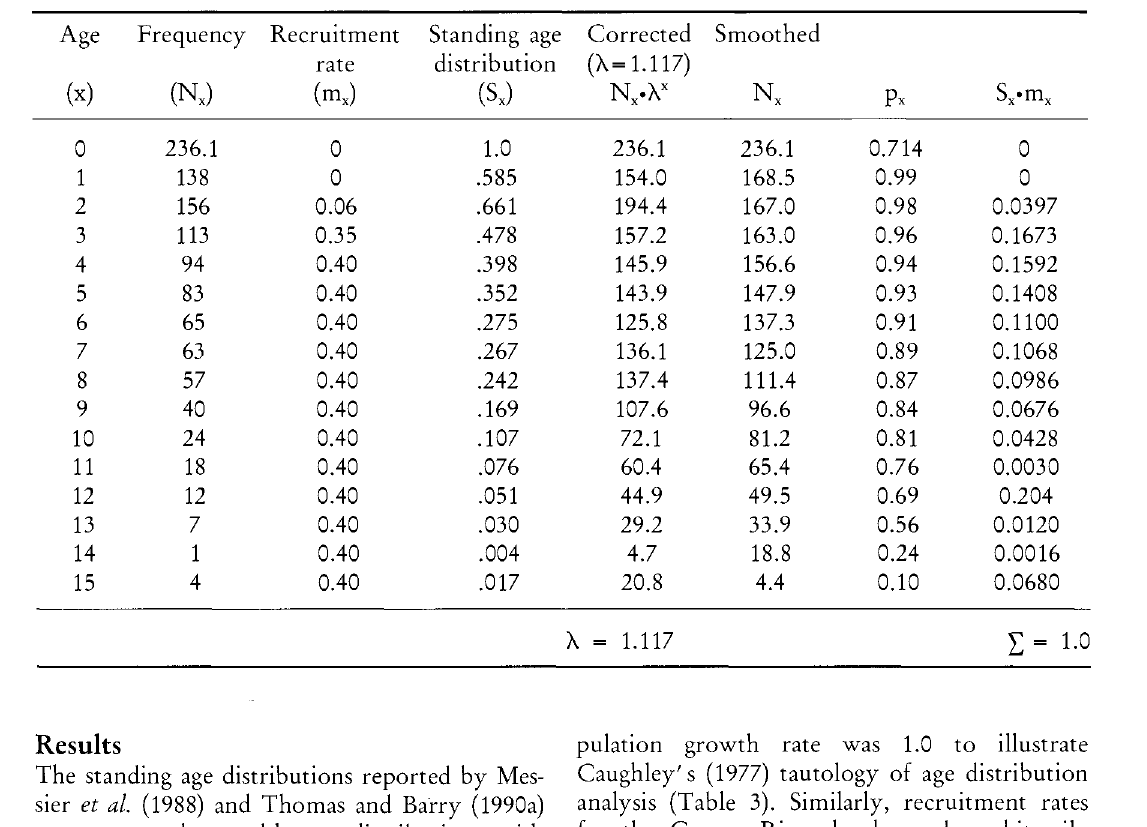
Table 1. The life table for the Georj ;e River carib ou herd as i developed by Messier et al.